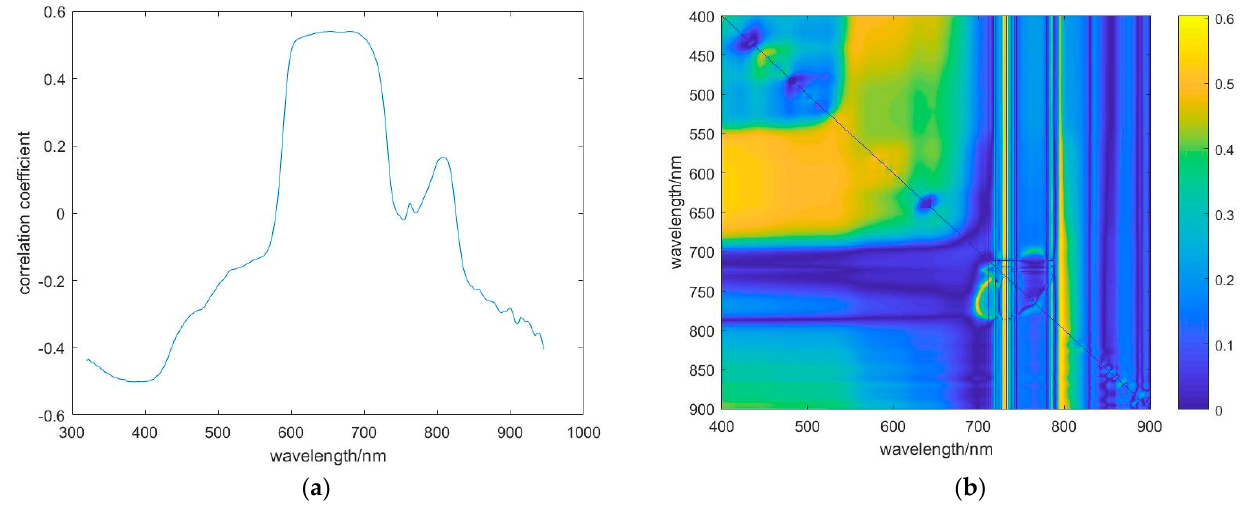
Figure 8. Pearson correlation analysis of single band, band ratio, and SPM concentration: ( a ) single band; ( b ) band ratio.